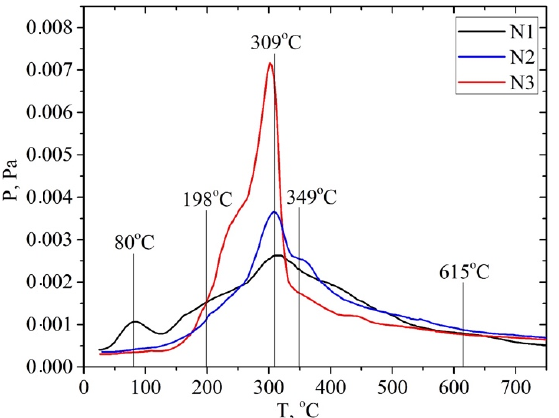
Figure 7. P/T curves of vapor pressure of gaseous products measured at temperature of pyrolysis: solids after hydrolysis of materials based on apricot seed shells: N1—solid after alkaline pretreatment; N2—solid after acid pretreatment; N3—solid after pretreatment with steam explosion.